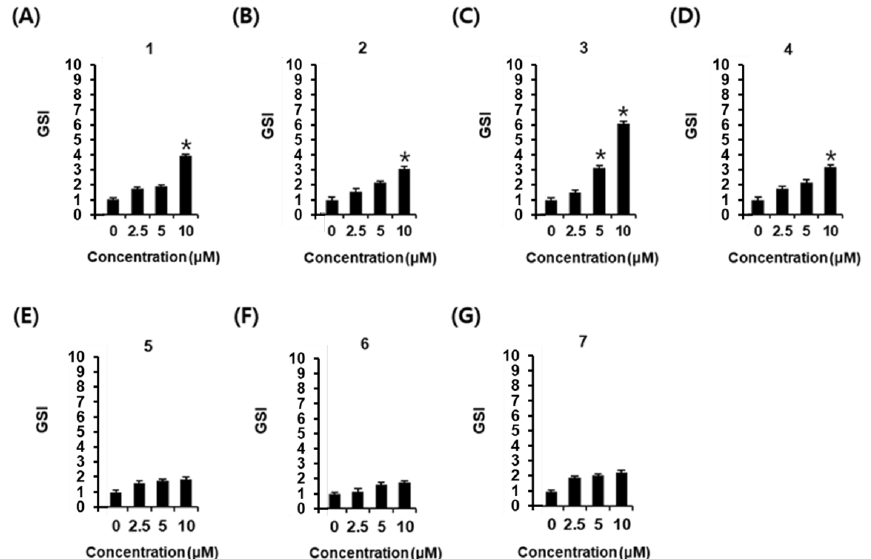
Figure 3. Effects of phenylpropanoids 1 – 7 on glucose-stimulated insulin secretion in INS-1 cells. Effect of compounds 1 – 7 ( A – G ) compared with the control (0 µ M) on GSIS in INS-1 cells for 1 h by insulin secretion assay. The fold change in GSIS was expressed in terms of the glucose stimulated index (GSI, 16.7 mM/2.8 mM glucose for 1 h). ( n = 3 independent experiments, * p < 0.05, Kruskal–Wallis nonparametric test). Data represent the mean ± SEM.